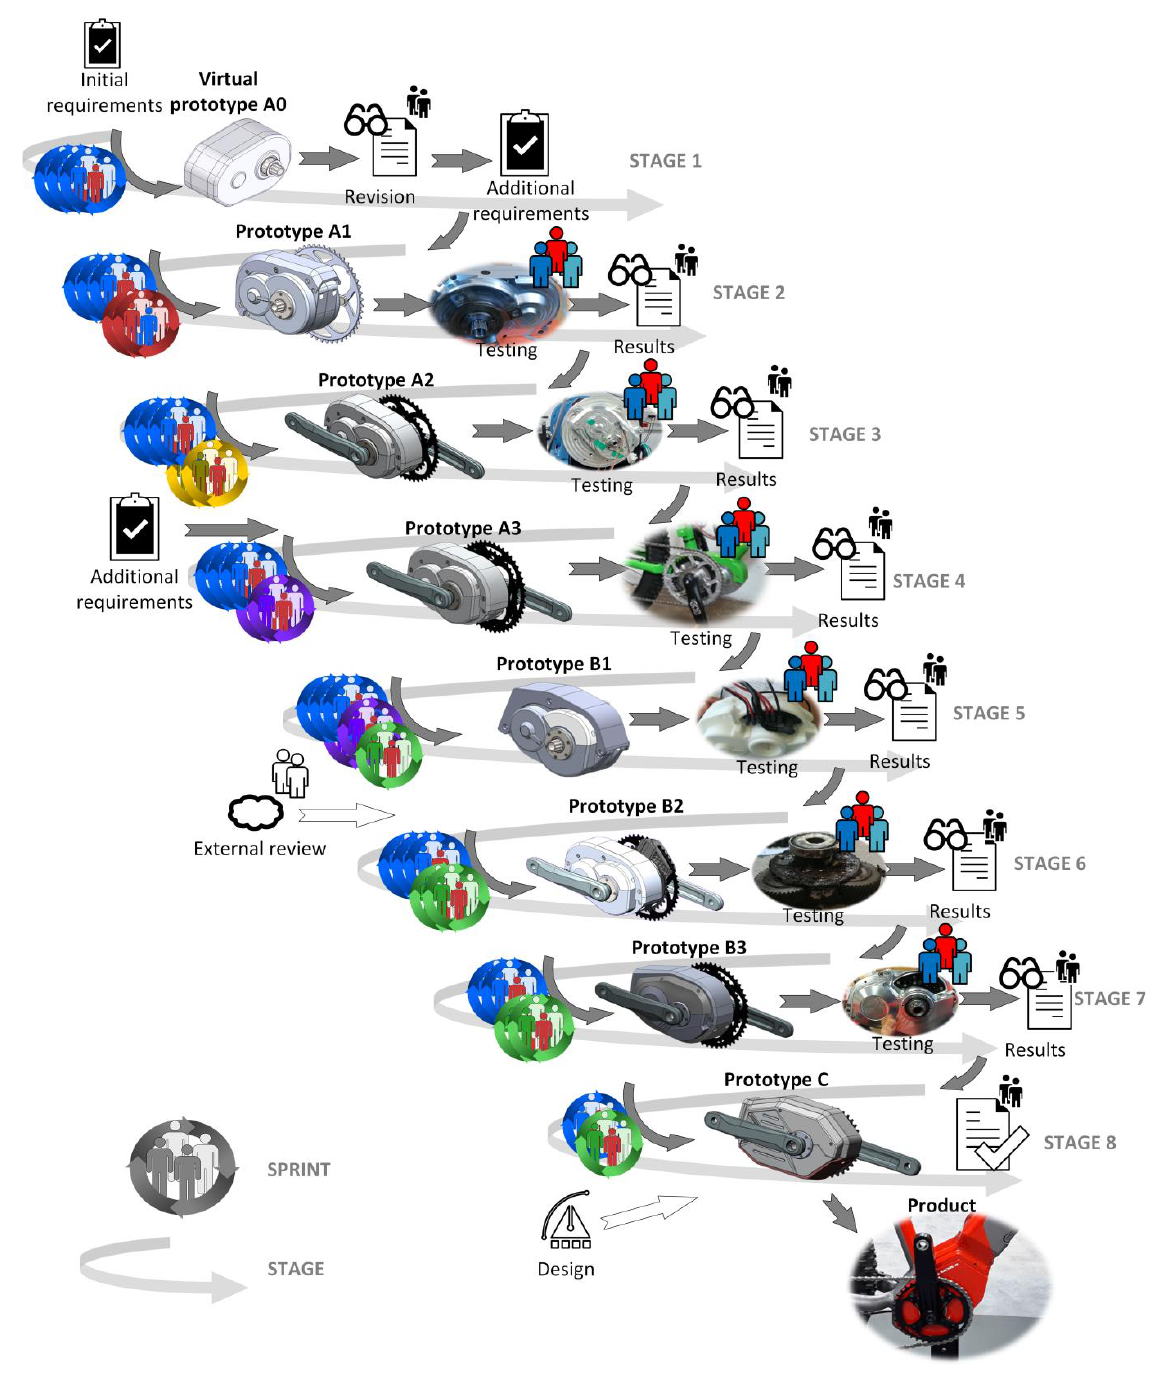
Figure 2. The drive system’s development